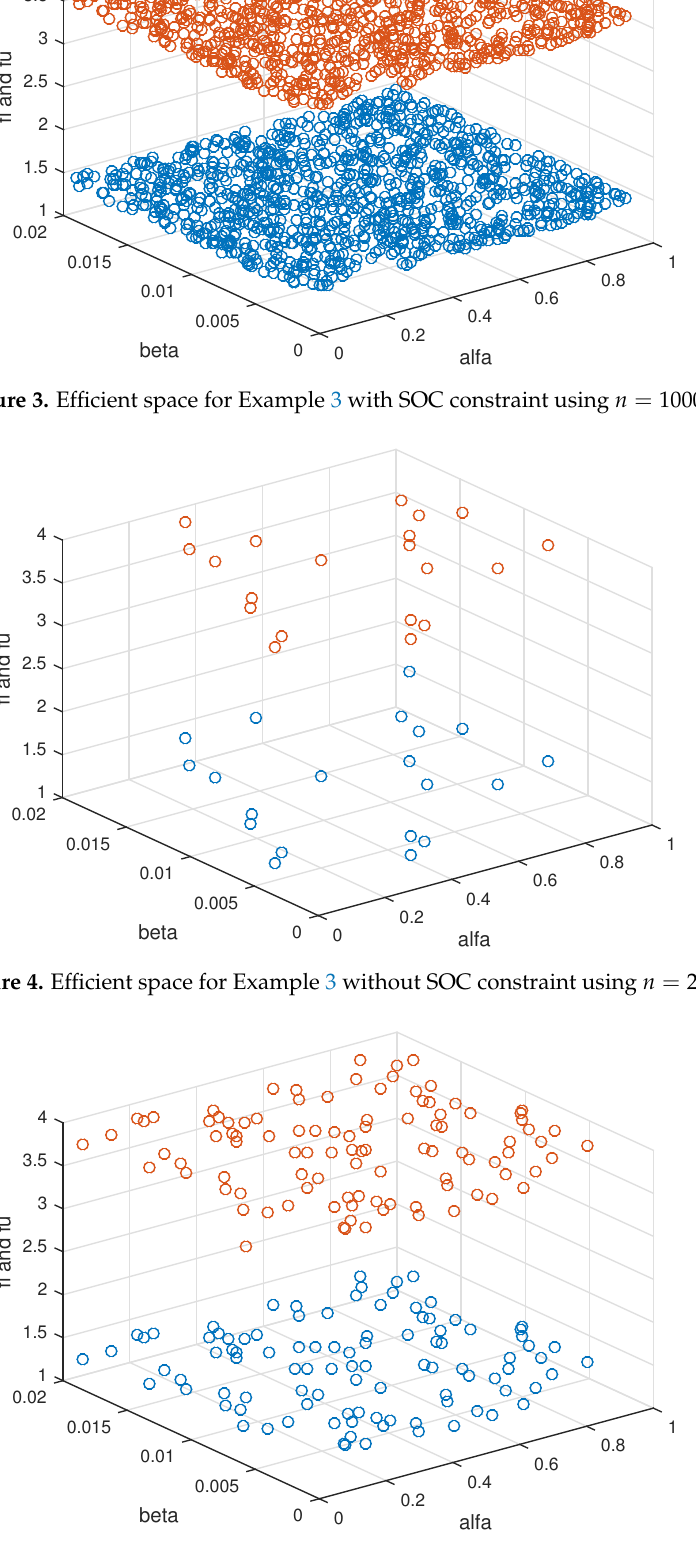
Figure 5. Efficient space for Example 3 without SOC constraint using n =